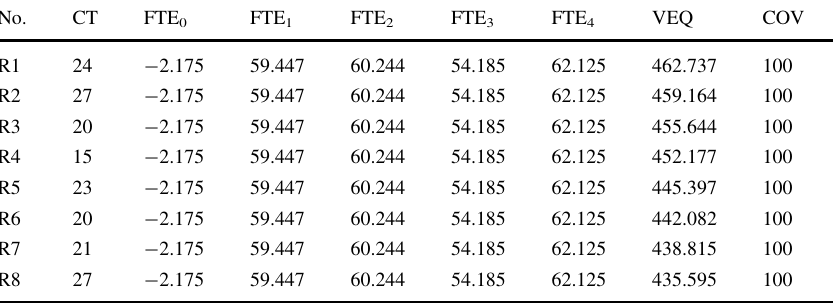
Table 2 Scenario analysis 1—discounting rates